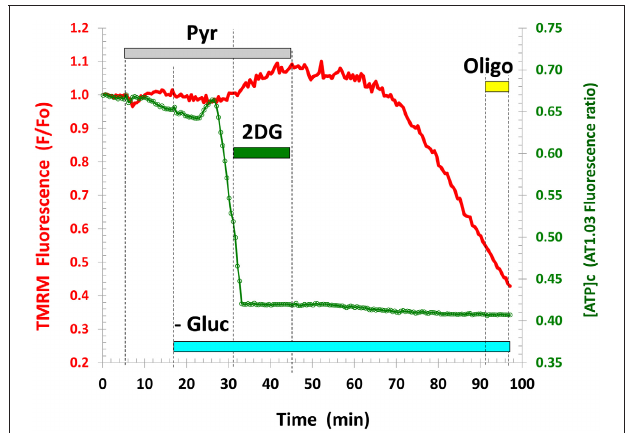
FIGURE A1 | Application of pyruvate (Pyr) to the resting neurons neither increased the basal [ATP]c, nor prevented its drop following glucose removal. All agent concentrations are the same as in Figure 1 . Similar results were observed in 10 neurons (3 separate experiments).